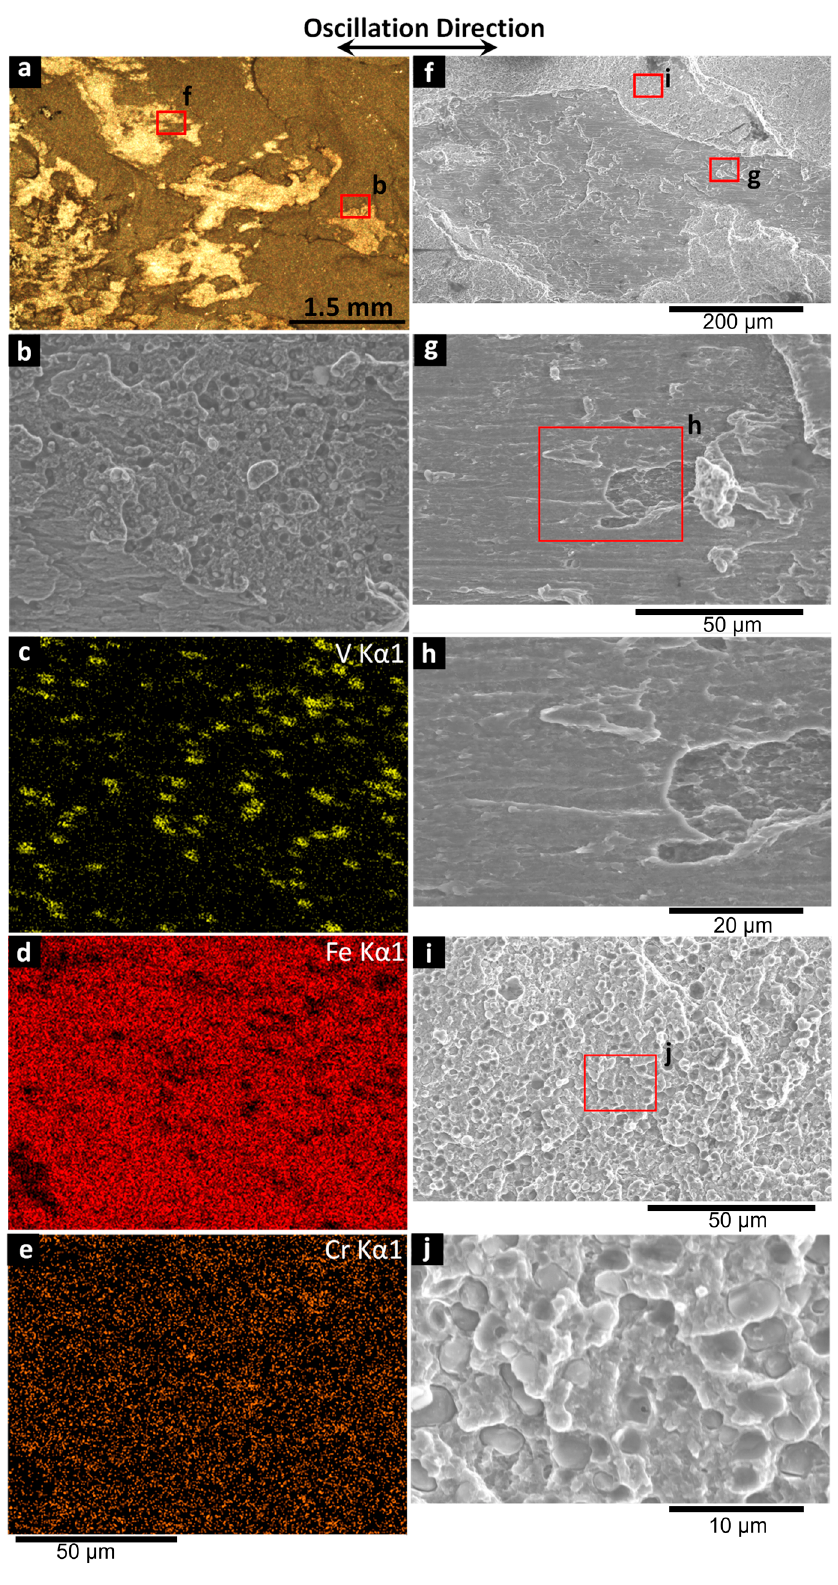
Figure 15. Images of the fracture surface after tensile fracture of LF weld under ( a ) stereomicroscopy, ( b ) SEM, ( c – e ) EDS mapping, and ( f – j ) SEM.